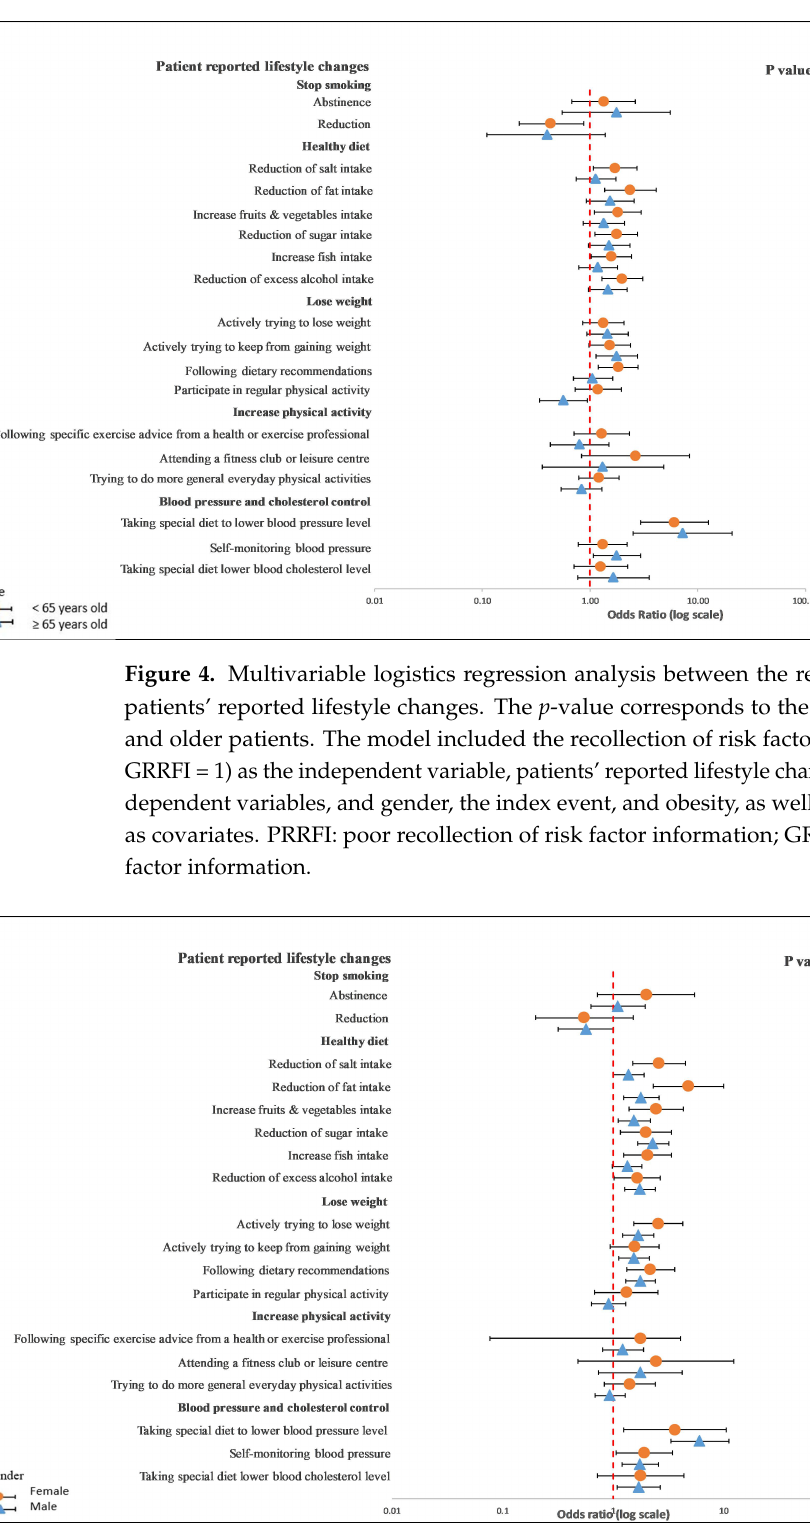
Figure 5. Univariable logistics regression analysis between the recollection of risk factors and patients’ reported lifestyle changes in female and male patients. The p -value corresponds to the interaction between female and male patients. The model included the recollection of risk factors (PRRFI = 0 and GRRFI = 1) as the independent variable and patients’ reported lifestyle changes (no = 1 and yes = 1) as the dependent variables. PRRFI: poor recollection of risk factor information; GRRFI: good recollection of risk factor